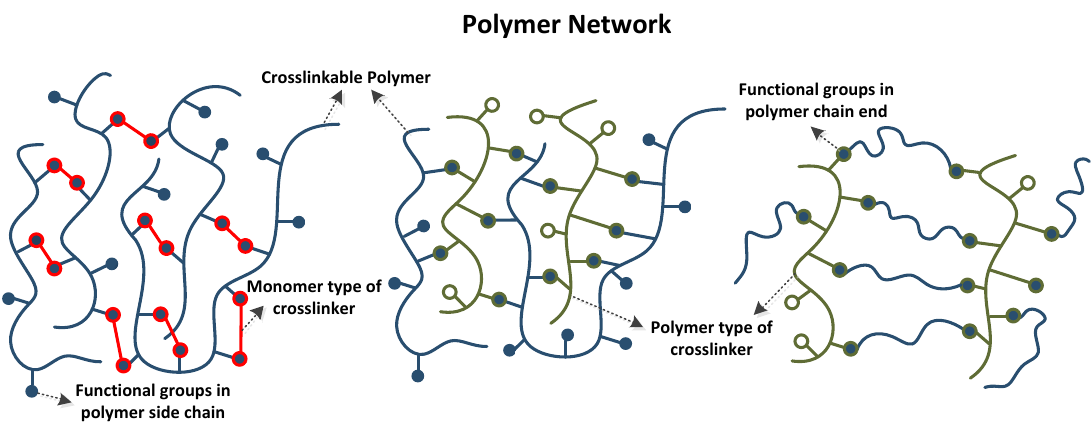
Figure 6. Schematic examples of different types of common polymer